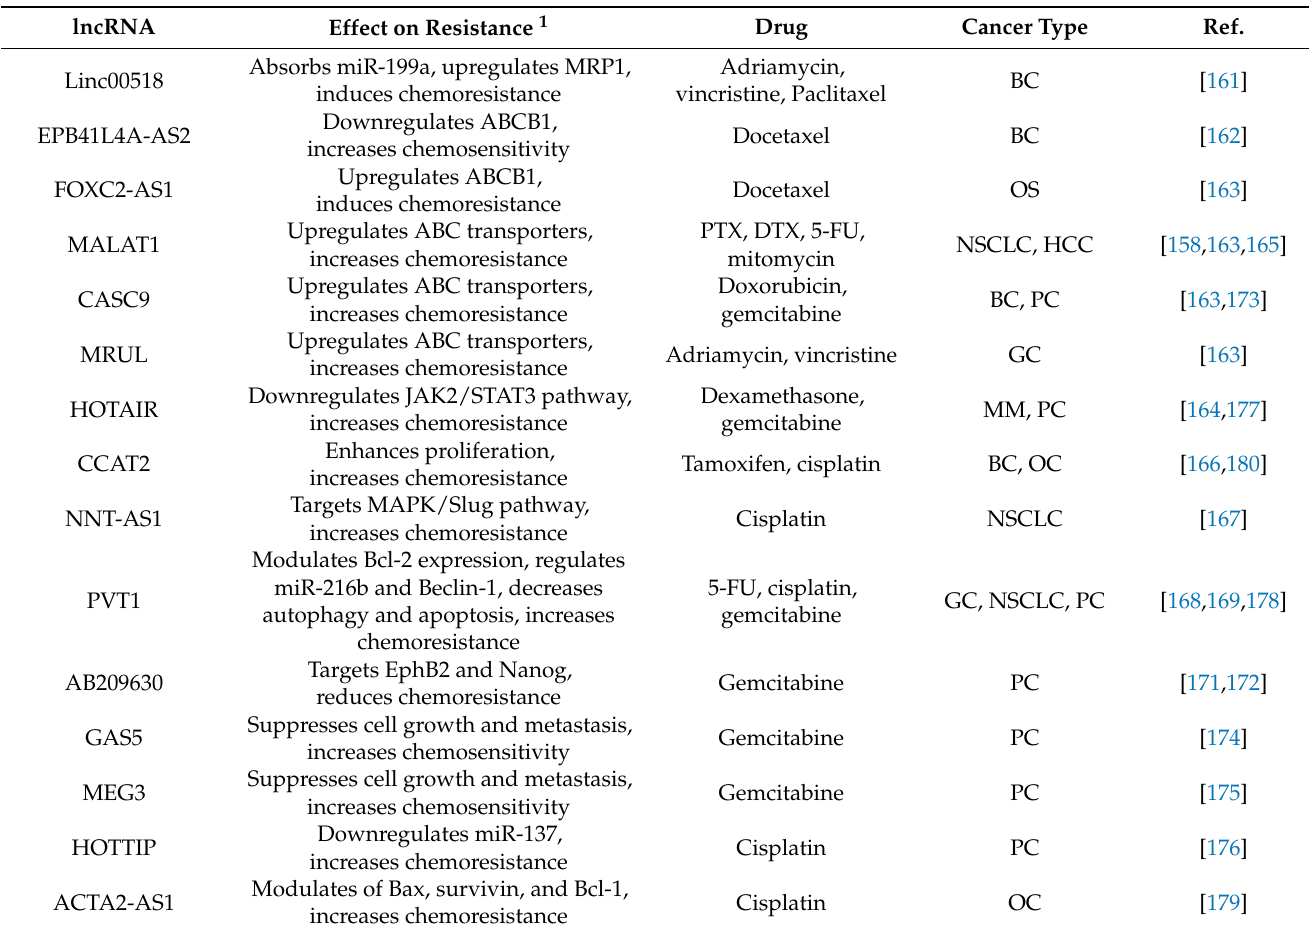
Table 3. lncRNAs involved in the regulation of cancer therapy